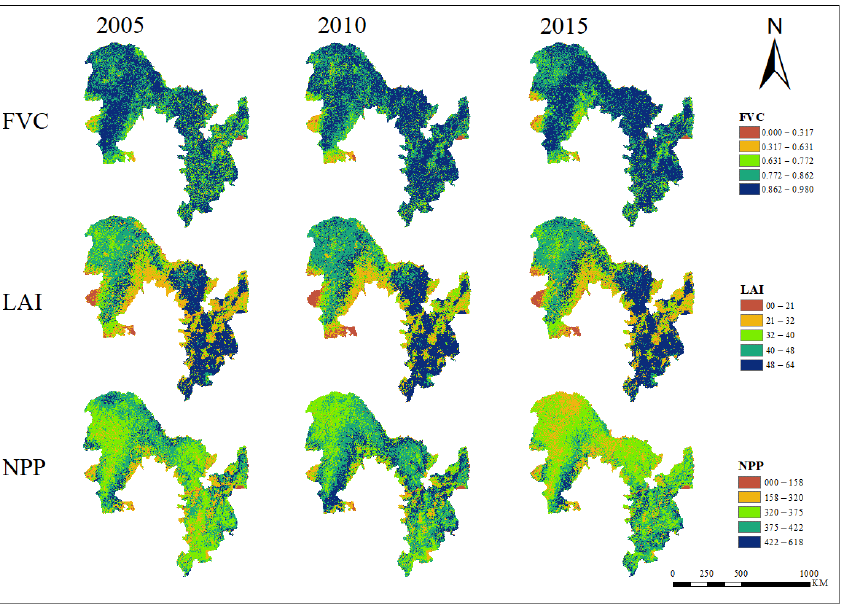
Figure 5. Spatial distribution of three types of EQ at different levels in the NFB from 2005 – 2015. Note: FVC is fractional vegetation coverage, NPP is net primary productivity, and LAI is leaf area index. Table 6. Area transfer matrix of different NPP levels in the NFB from 2005 – 2015.